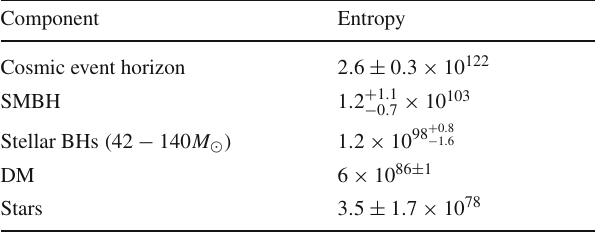
Table 1 Entropy of different components of universe Component